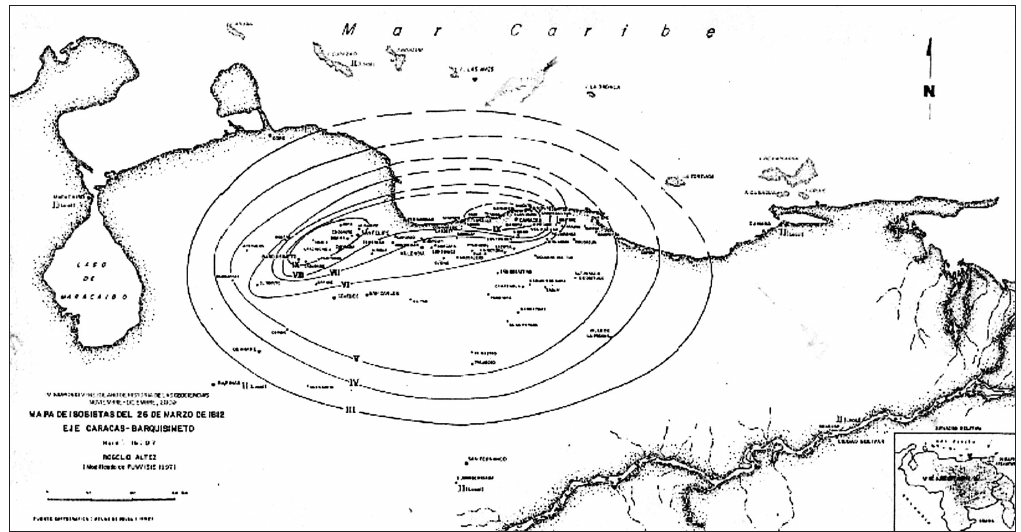
Fig. 5. Map of intensities for the 1812 earthquake in Caracas (Altez,